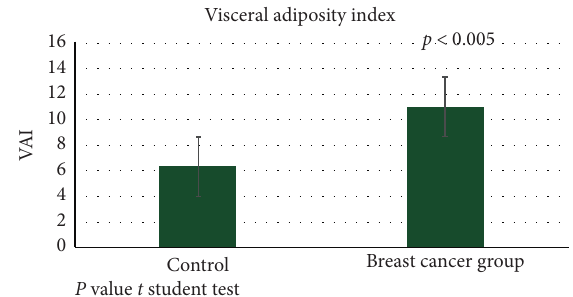
Figure 1: Visceral adiposity index in breast cancer